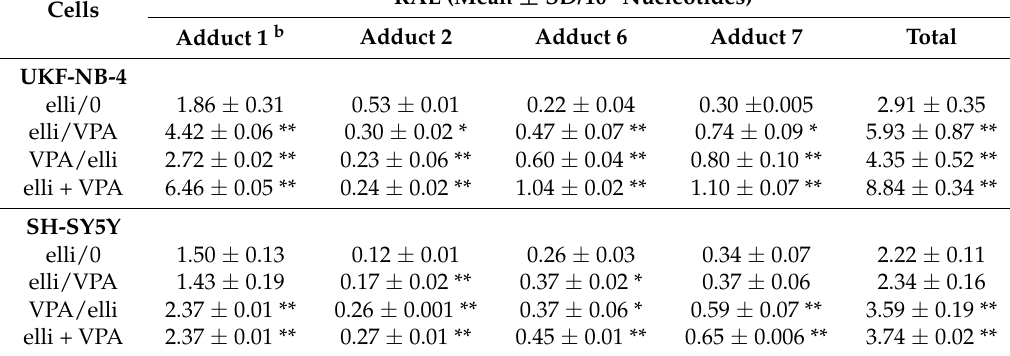
Table 2. DNA adduct formation by ellipticine in neuroblastoma UKF-NB-4 and SH-SY5Y cell lines treated with ellipticine and this drug combined with VPA. Experimental treatment conditions are described in Table 1.